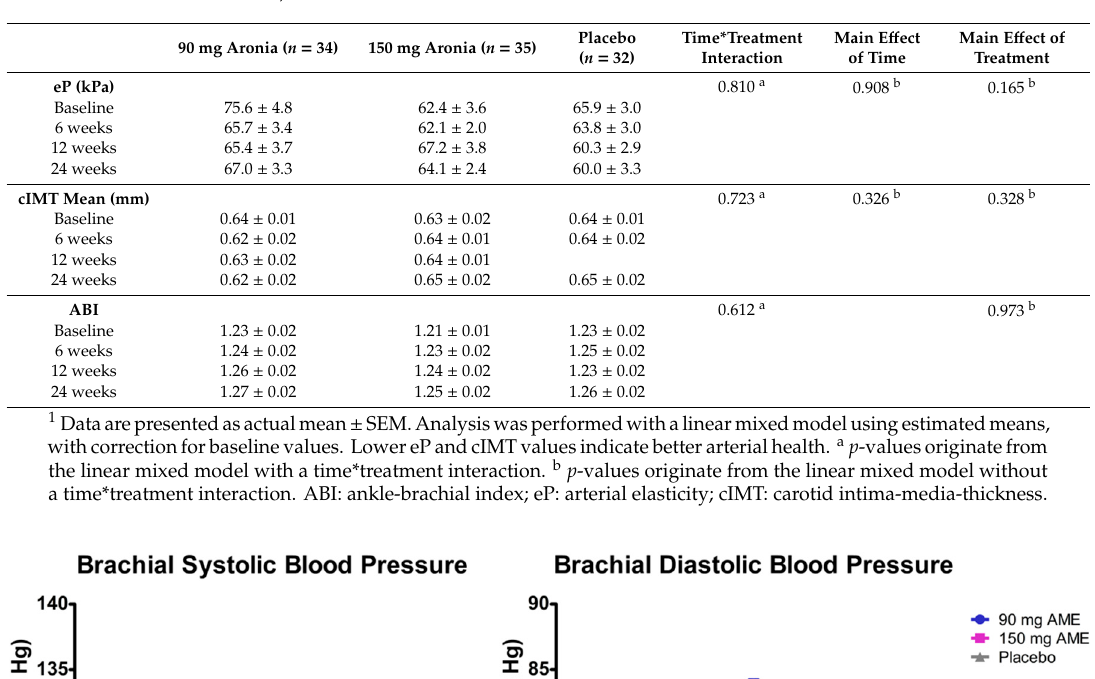
Table 3. The e ff ect of Aronia melanocarpa extract (AME) supplementation on arterial elasticity, intima-media thickness, and ABI 1 .